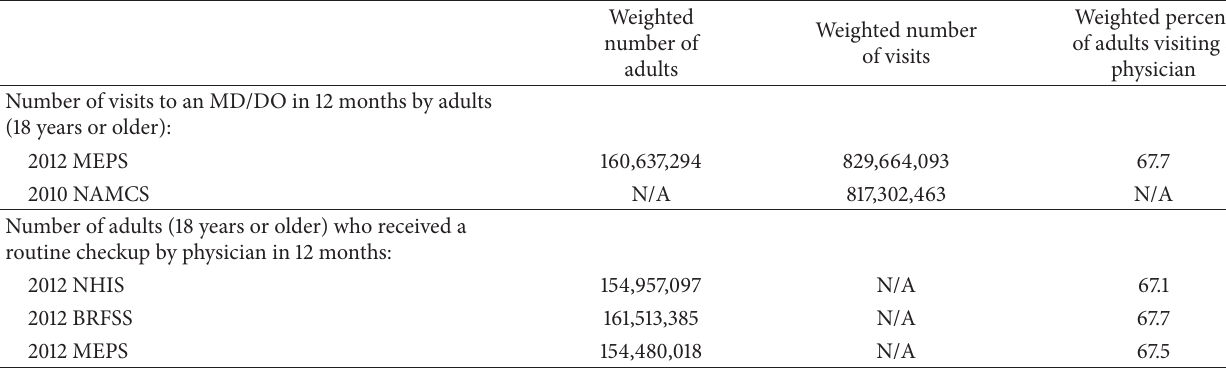
Table 4: A comparison of utilization of office-based physician services across databases in the US.